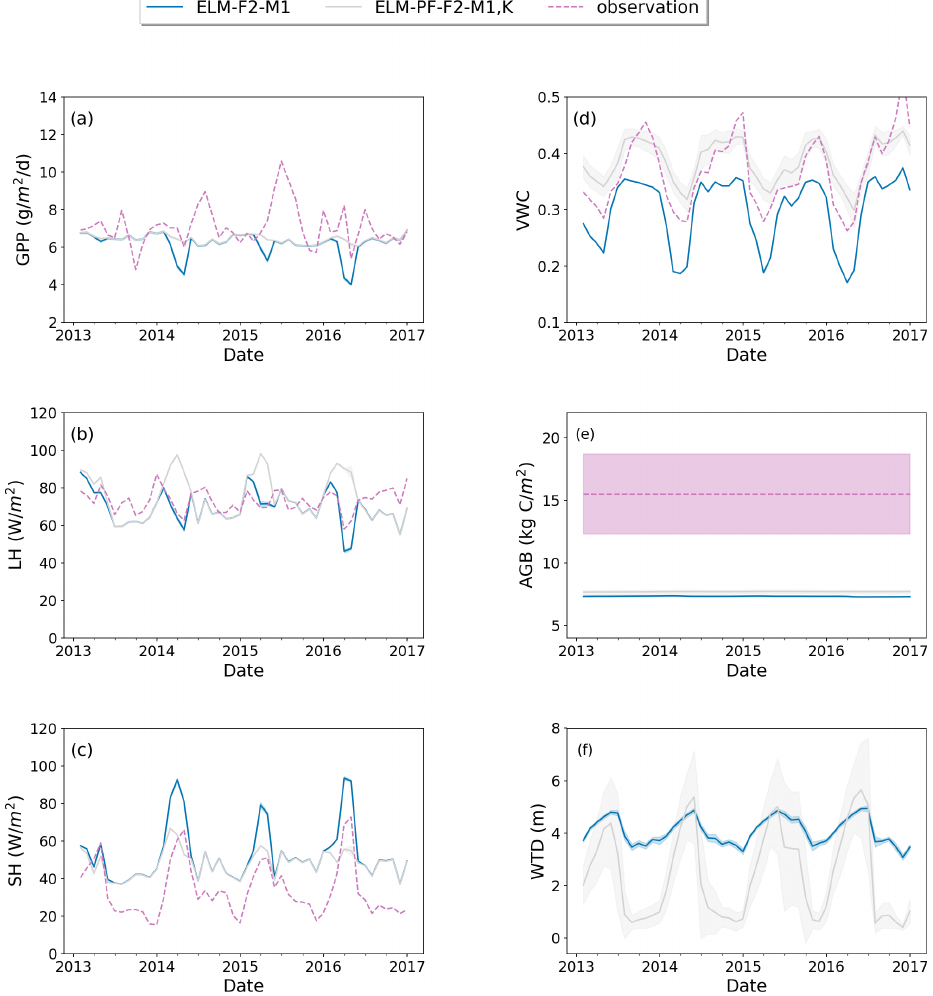
Figure 5. Simulated GPP (a) , LH (b) , SH (c) , top 15cm VWC (d) , AGB (e) , and WTD (f) for simulations with the default soil property (ELM-F2-M1) and the soil property derived from Kupers et al. (2019b) (ELM-PF-F2-M1, K). Dashed line is the observation if available. Solid line is the spatial average, and the shaded area is the standard deviation over the simulation domain. Table 2. Random forest model performance on the simulated aboveground biomass (AGB) and water table depth (WTD) from the site-wide and 50ha locations, respectively. Model performance is quantified by mean absolute percentage error (MAPE; %) and percent of variance explained (VAR ex ; %). The paired data separated by “/” in each column are metrics for training data (left) and unseen test data (right). Subscript RF1 indicates the random forest models using topographic features, while subscript RF2 indicates a model using simulated soil moisture as a predictor in addition to the predictors used in RF1